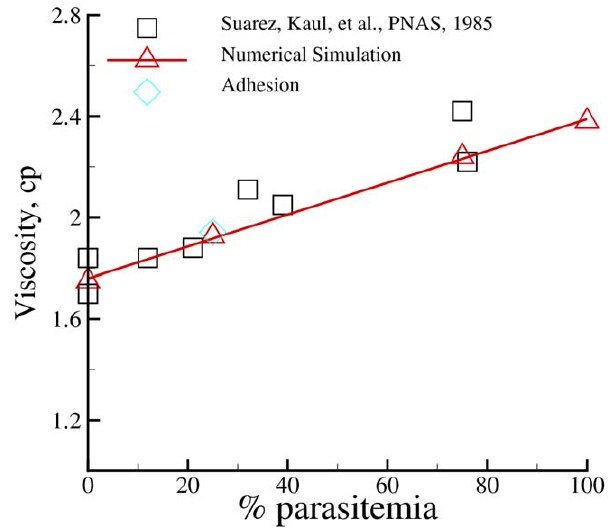
Figure 9. Shape representation of healthy RBCs and Pf-RBCs quantified by the shifted eigen-value of the gyration tensor at different stages of parasite development at T ~ 23 o C . The shift is done by subtracting the eigen-value of the equilibrium biconcave shape. C ~ 0 : 05 is the volume fraction of a single RBC. The shear moduli of Pf-RBCs for different stages are given in Table 1. The bending stiffness and the membrane viscosity in all cases are set to 2 : 4 | 10 { 19 J and 0 : 022 Pa : s , respectively.